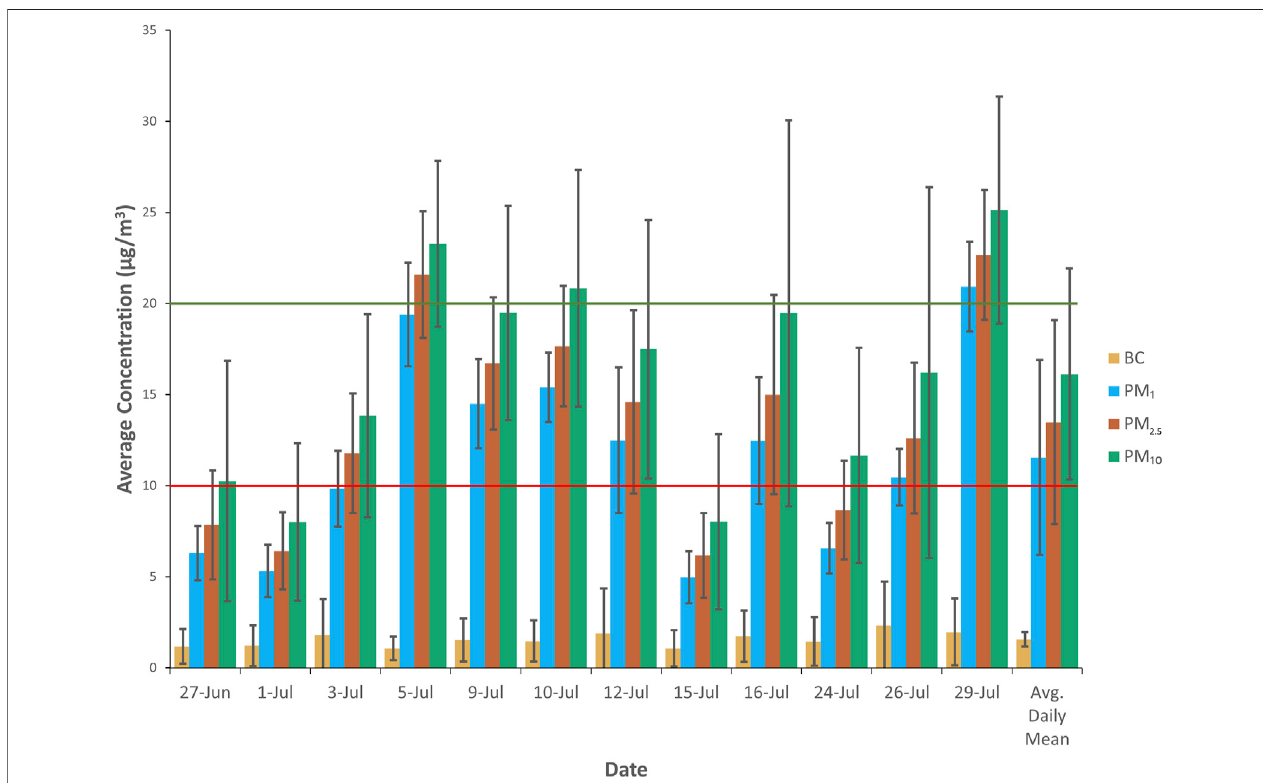
FIGURE 2 | Daily mean concentrations of PM 1 , PM 2.5 , PM 10 , and BC. Error bars represent standard deviations from the daily mean for each pollutant. The red horizontallineat10 μ g/m 3 andthegreenhorizontallineat20 μ g/m 3 re fl ectWorldHealthOrganizationguidelinesforthelowestannualmeanconcentrationsofPM 2.5 and PM 10 , respectively, at which cardiopulmonary and lung cancer mortality increase with more than 95% con fi dence (World Health Organization, 2006).